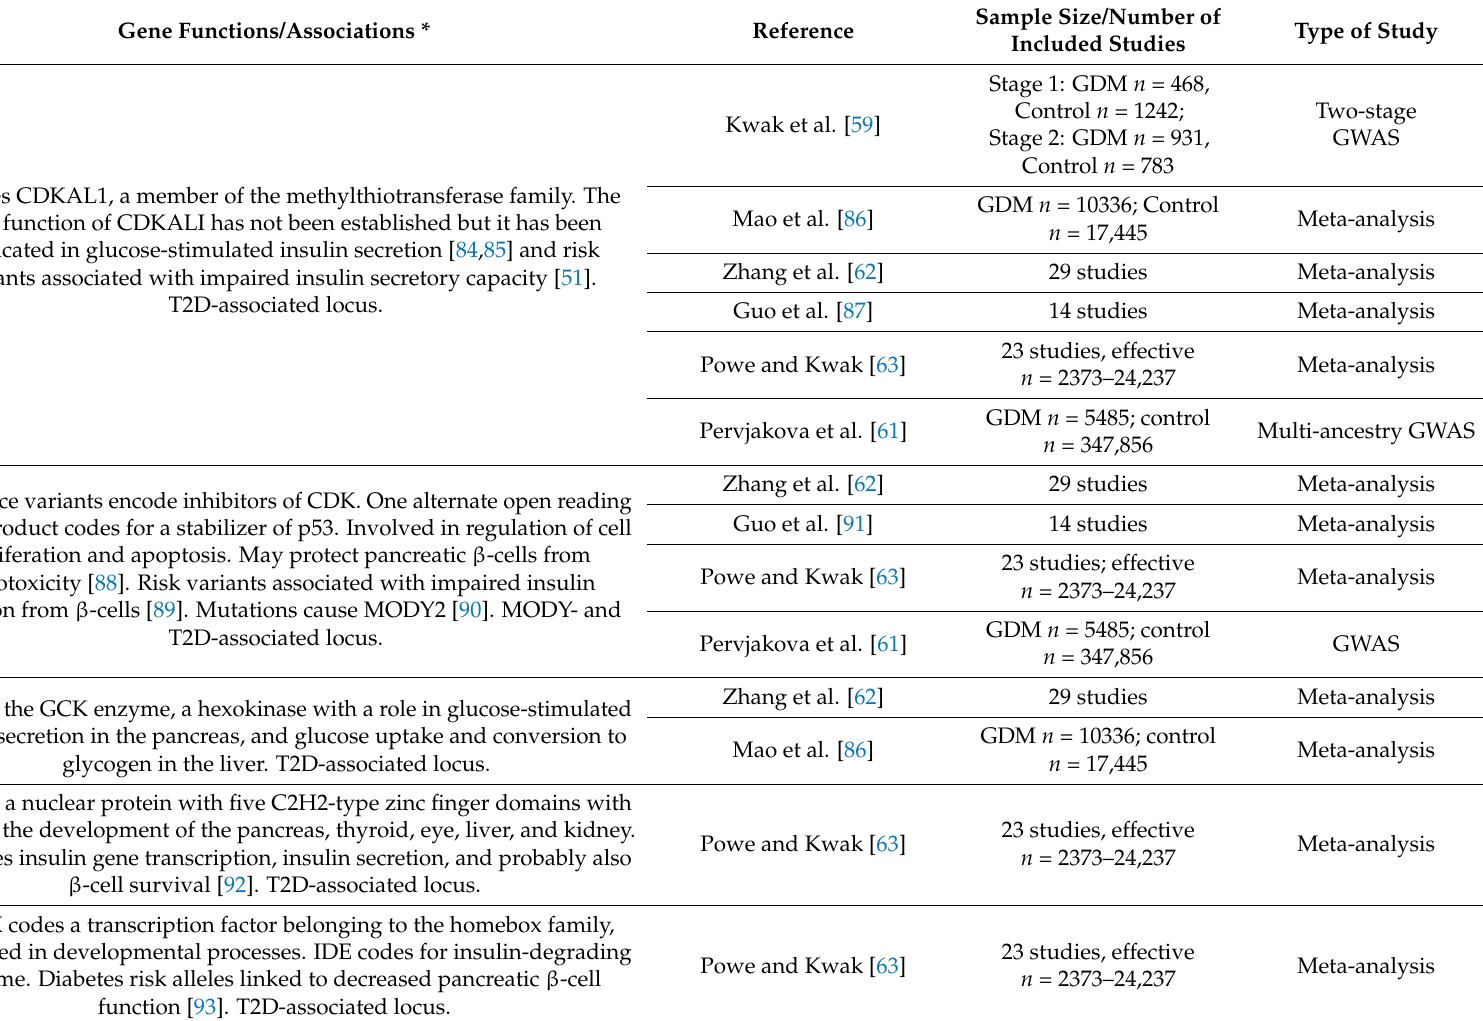
Table 1. Genes associated with GDM in recent meta-analyses or